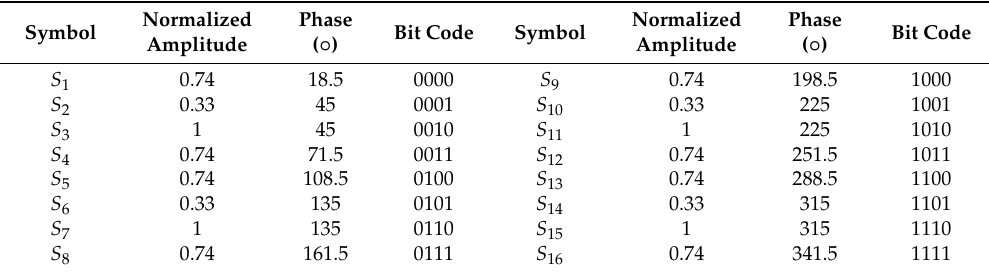
Table 1. Amplitudes, phases, and bit codes of the reproduced 16-Quadrature Amplitude modulation (16-QAM).